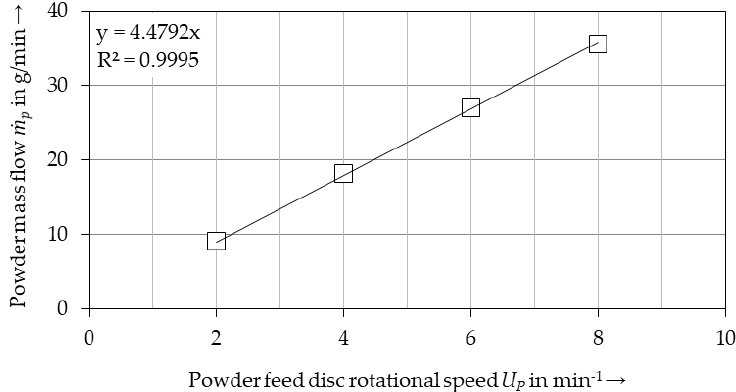
Figure 6. Measured powder mass flow in relation to the powder feed disc rotational speed U p with a grain fraction of − 53 + 20 µ m [1]. Reprinted with permission from Ref [1]. Copyright 2020, Fraunhofer Verlag.